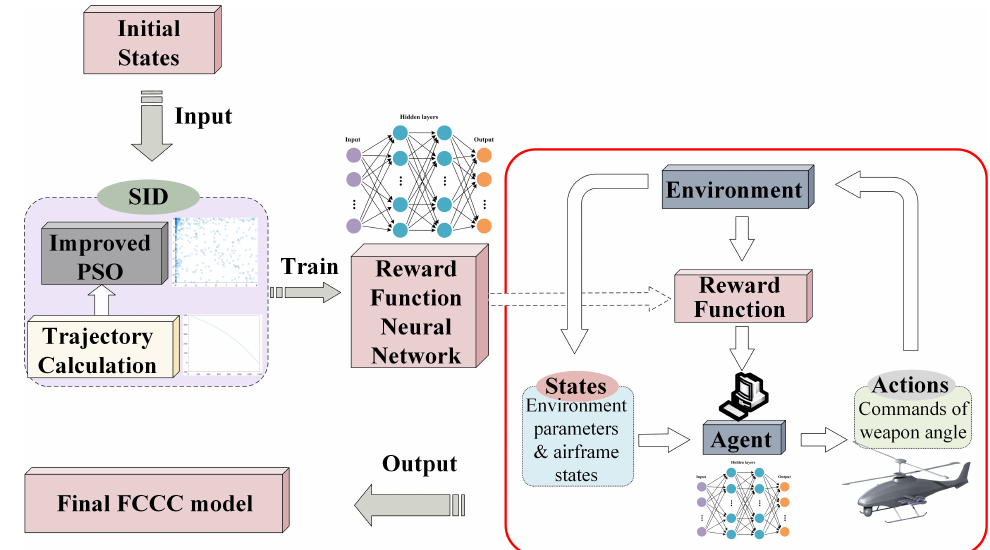
Figure 3. The framework of SID-IRL fire-control command calculation